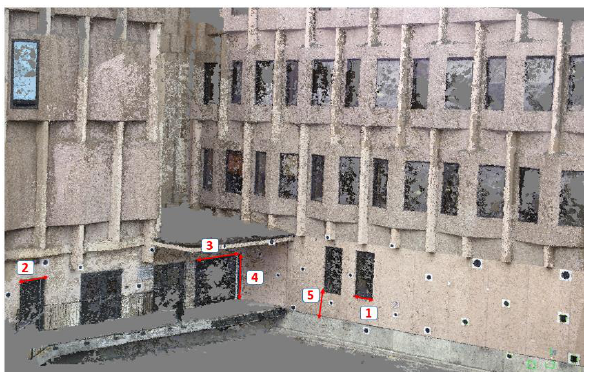
Figure11. Image-based 3D point cloud